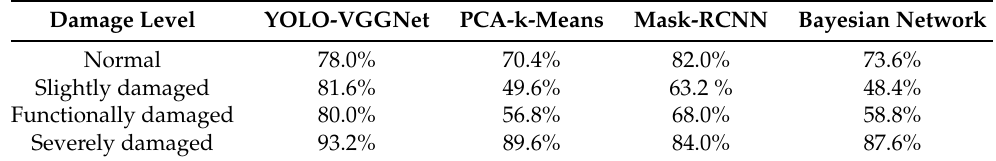
Table 4. The results of the damage level assessment.